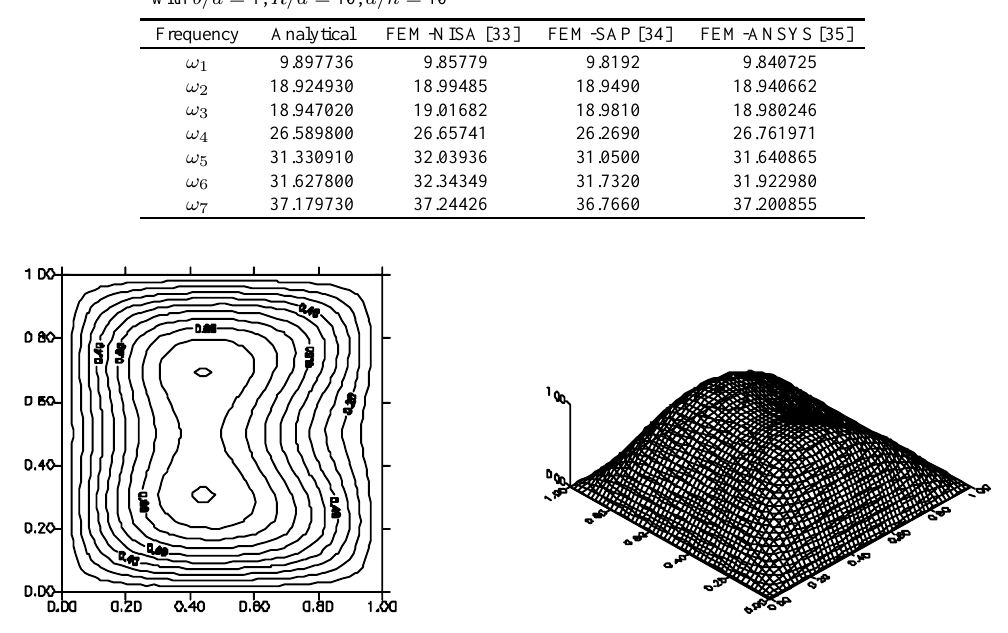
Table 1 Comparison of normalized frequencies between analytical and FEM solutions for panels